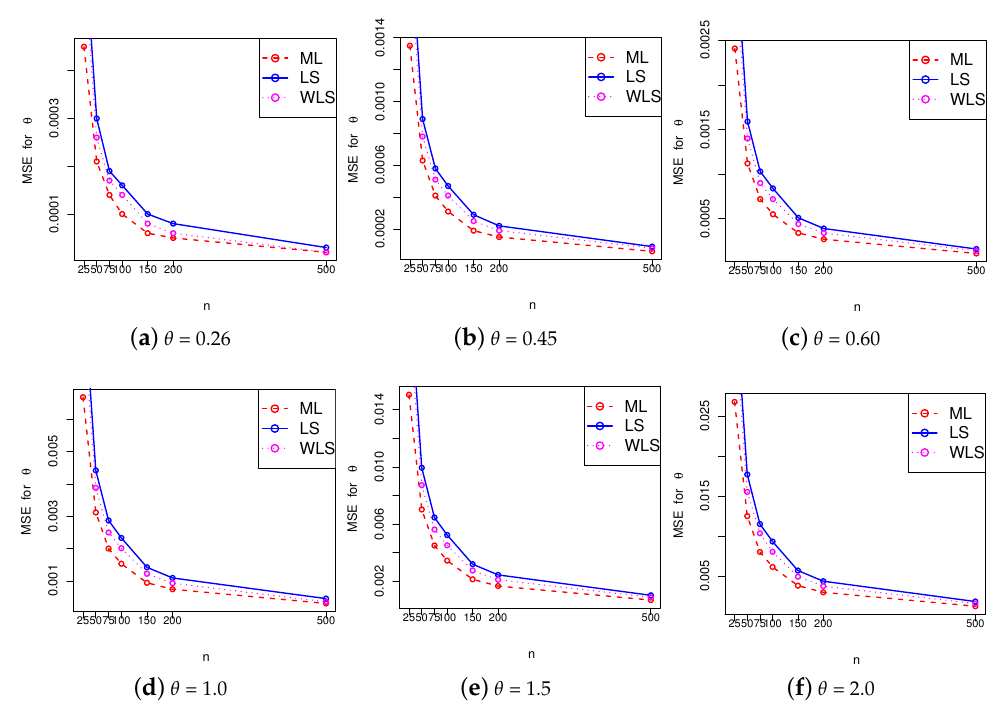
Figure 4. Graphical comparison of the MSEs obtained from ML, LS, and WLS estimation methods for ( a ) θ = 0.26, ( b ) θ = 0.45, ( c ) θ = 0.60, ( d ) θ = 1.0, ( e ) θ = 1.5 and ( f ) θ = 2.0.